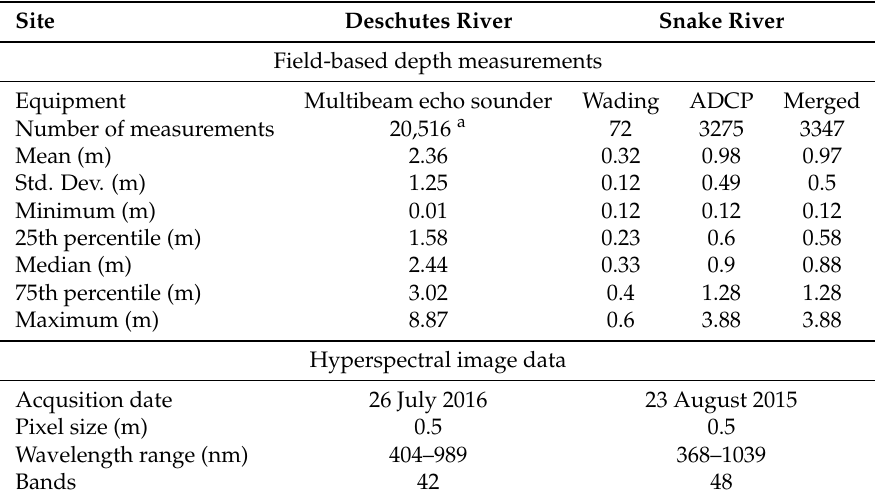
Table 1. Summary of field-based and remotely sensed data